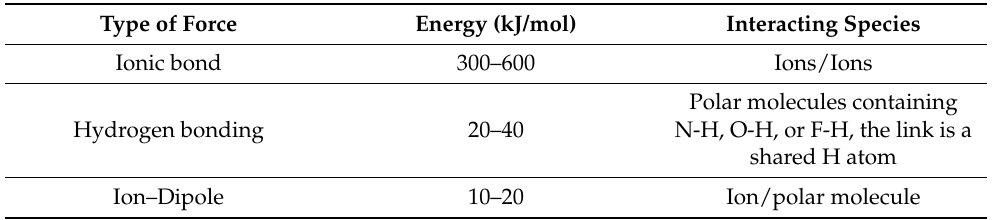
Table 1. Summary of the major intermolecular forces. For the sake of energetic comparisons, the interionic ion–ion force is also